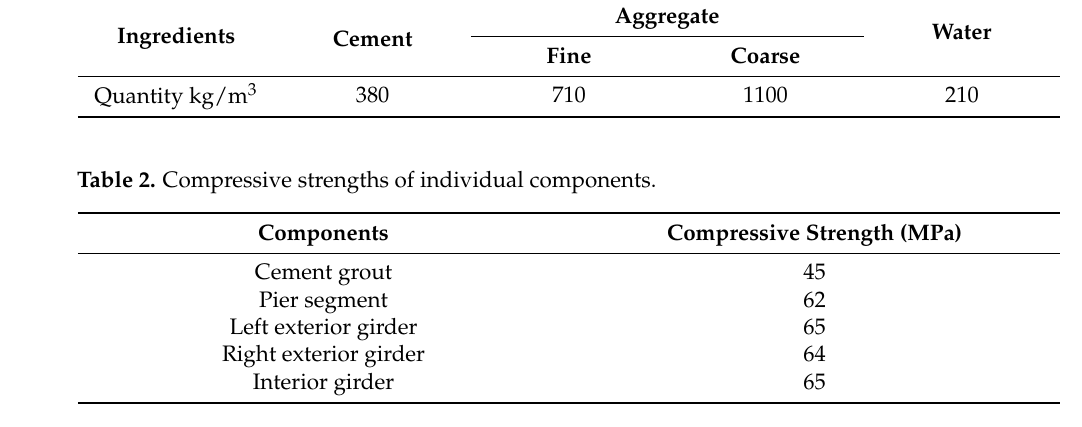
Figure 4. Application of tension to the PT tendons.